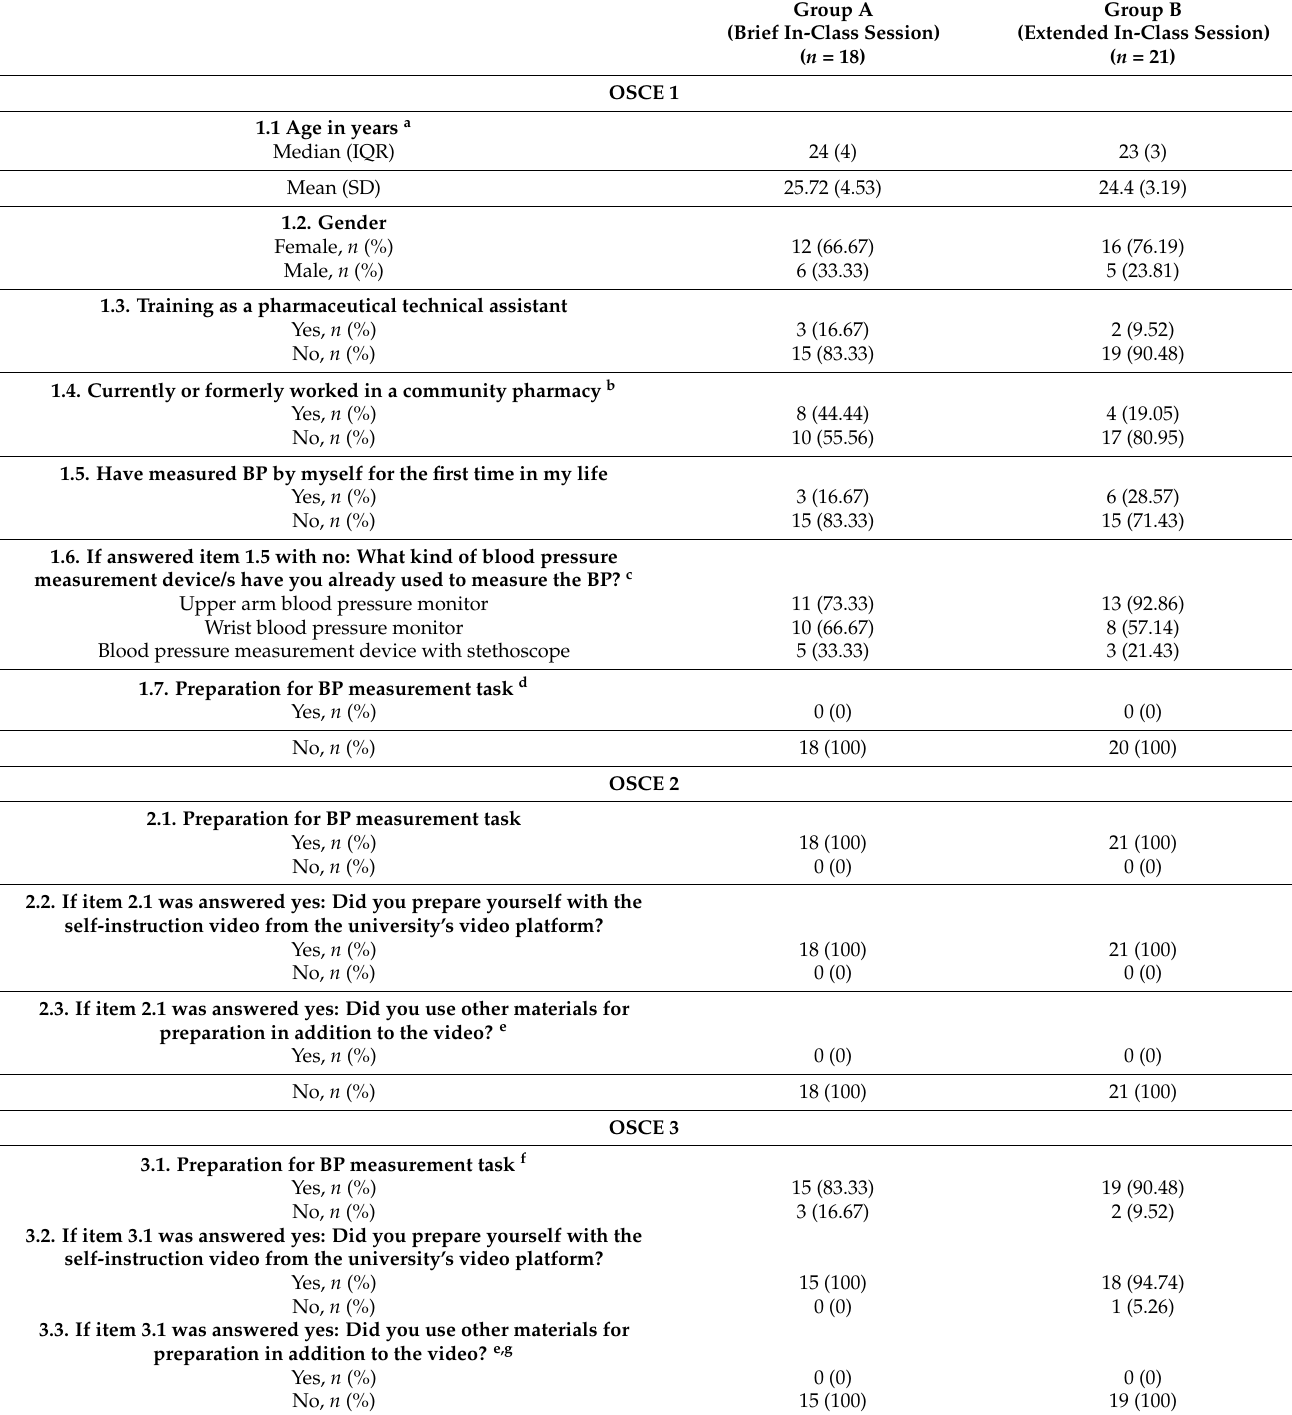
Table 1. Demographics of